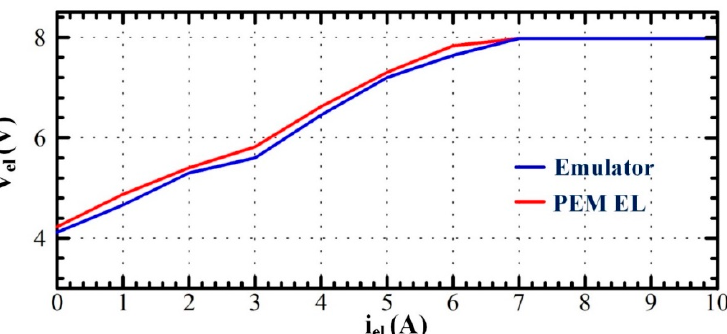
Figure 12. Comparison of the static characteristic between the developed emulator and real elec- trolyzer.